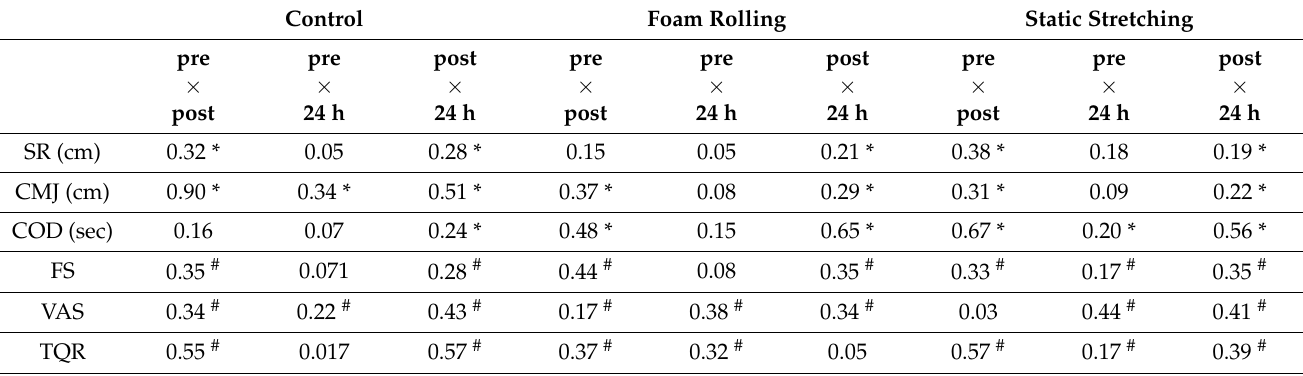
Table 2. Effect sizes.